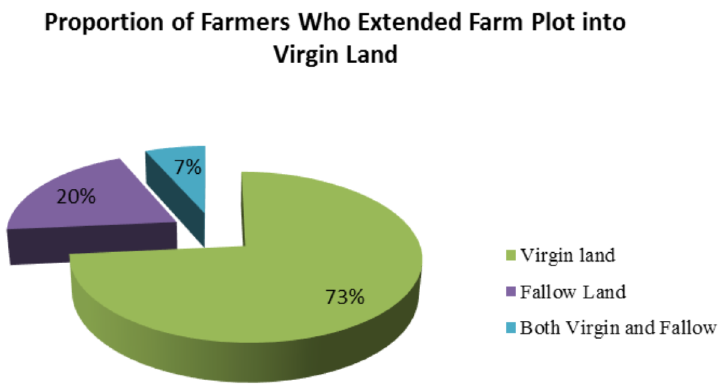
Figure 6. Proportion of Farmers Who Extended Farm Plots to Virgin